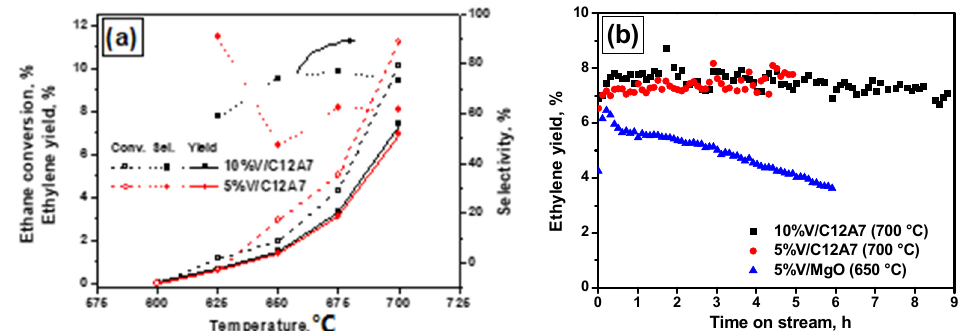
Figure 9. ( a ) Catalytic performance (ethane conversion, ethylene selectivity, and yield) of 5%V/C12A7 and 10%V/C12A7 in a model reaction of ethylene dehydrogenation. ( b ) Dependence of ethylene yield on time on stream for the V5%/C12A7 and V10%/C12A7 samples in comparison with a reference sample 5%V/MgO [28].